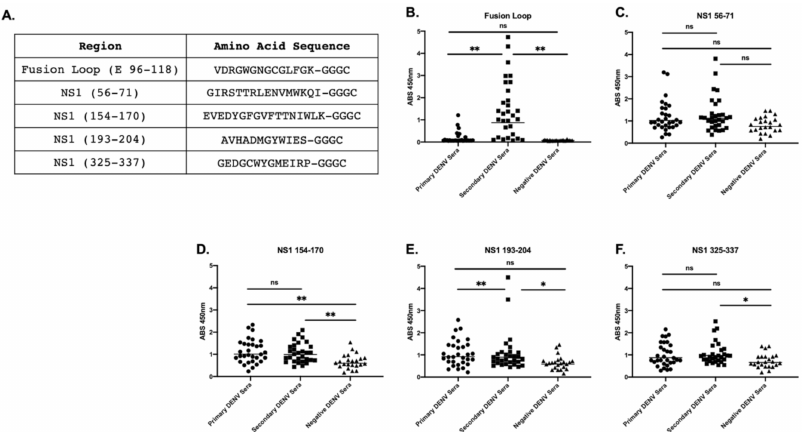
Figure 7. Five highly selected peptides were tested via IgG peptide ELISA. Five sequences were identified as highly selected among the 25 primary infected patients, and a terminal -GGGC was added to the peptides for the attachment of peptide to the ELISA plates ( A ). Sera from primary and secondary DENV-infected patients, as well as negative controls were then tested against peptide ELISA to identify whether sera bound to regions observed from the deep sequence-coupled biopanning results. Fusion loop peptide ( B ), NS1 56–71 ( C ), NS1 154–170 ( D ), NS1 193–204 ( E ), NS1 325–337 ( F ). * Indicates p < 0.05, ** p < 0.005 as determined by Kruskal–Wallis test of multiple